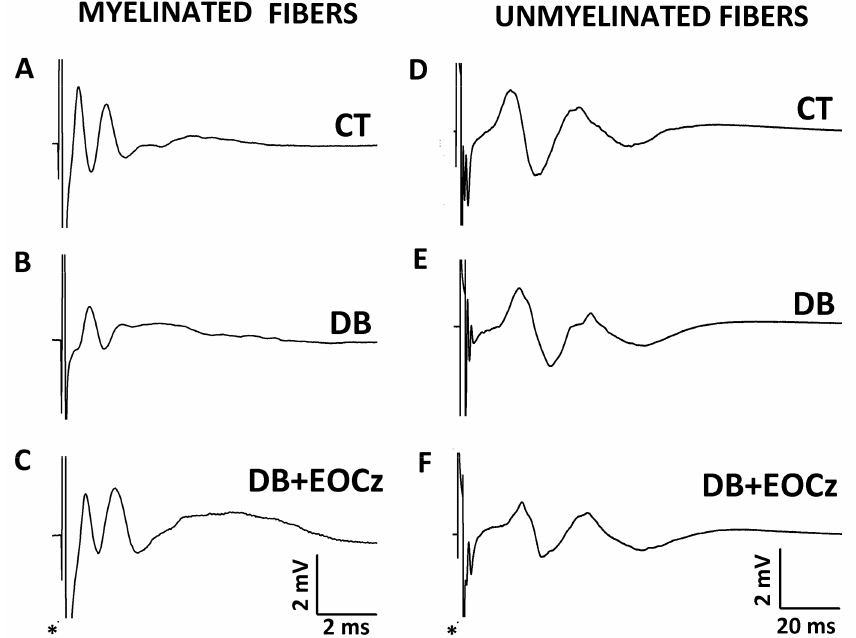
Figure 3. Representative traces of the compound action potential (CAP) of the vagus nerve. The left and right columns show the CAP traces of the myelinated or unmyelinated fibers, respectively, for control (CT, panel A or D ), diabetic (DB, panel B or E ), and diabetic animals treated with EOCz (DB + EOCz, panel C or F ). The asterisks indicate the stimulus